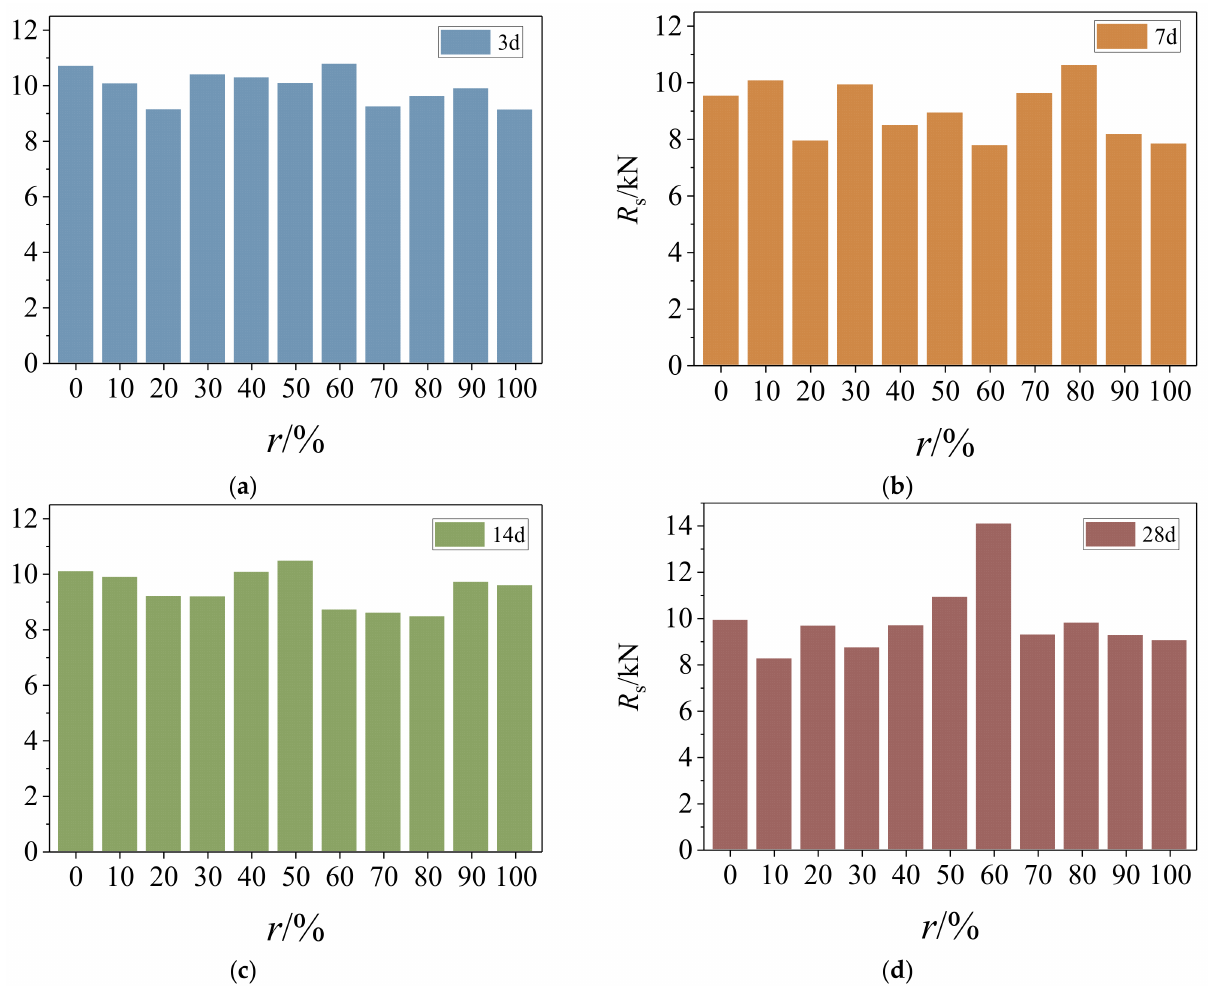
Figure 10. Residual strength of RAC with different replacement ratios: ( a ) 3 days. ( b ) 7 days. ( c ) 14 days. ( d ) 28